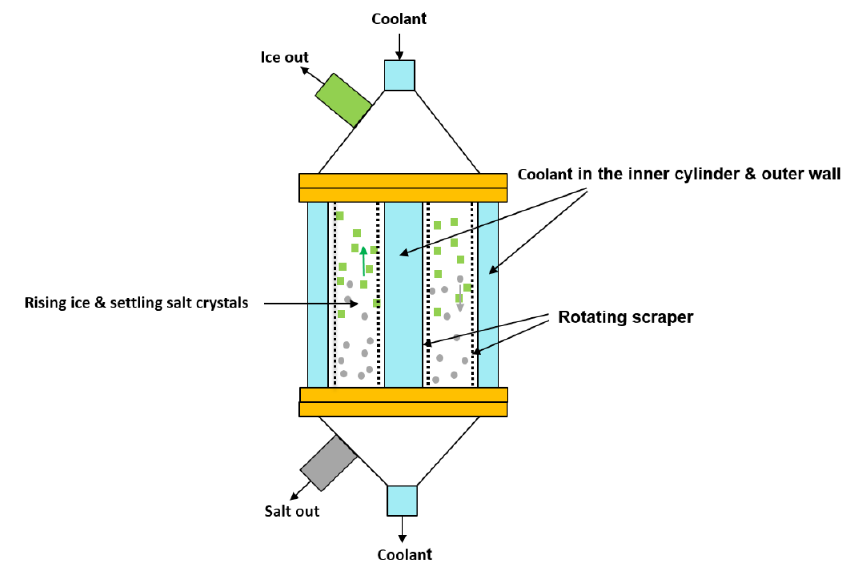
Figure 7. Schematic diagram of a cylindrical chilling module crystallizing unit for EFC, as described by Vaessen et al. [57].